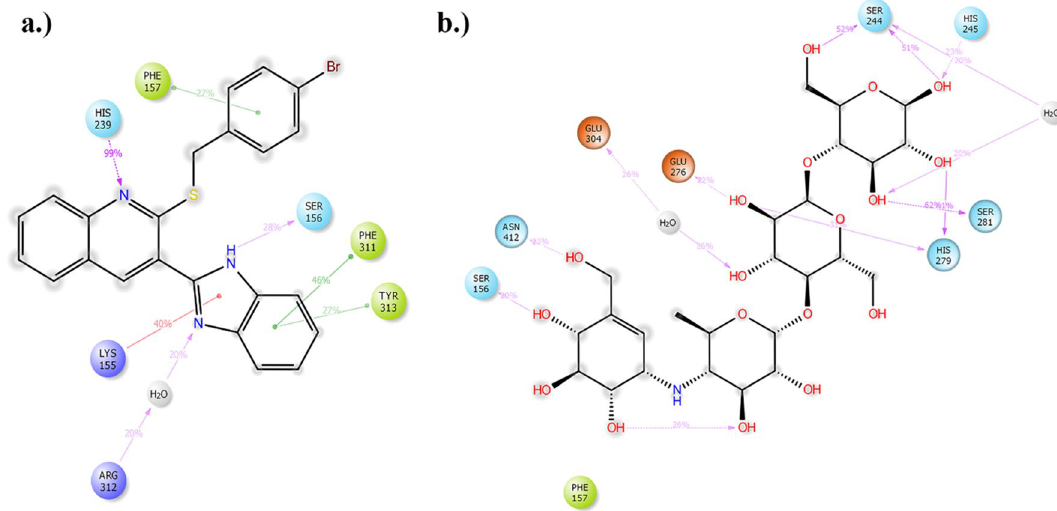
Figure 8. ( a ) 2D presentation of compound 6j interactions with the active site of the enzyme ( b ) 2D presentation of acarbose interactions with the active site of the enzyme.